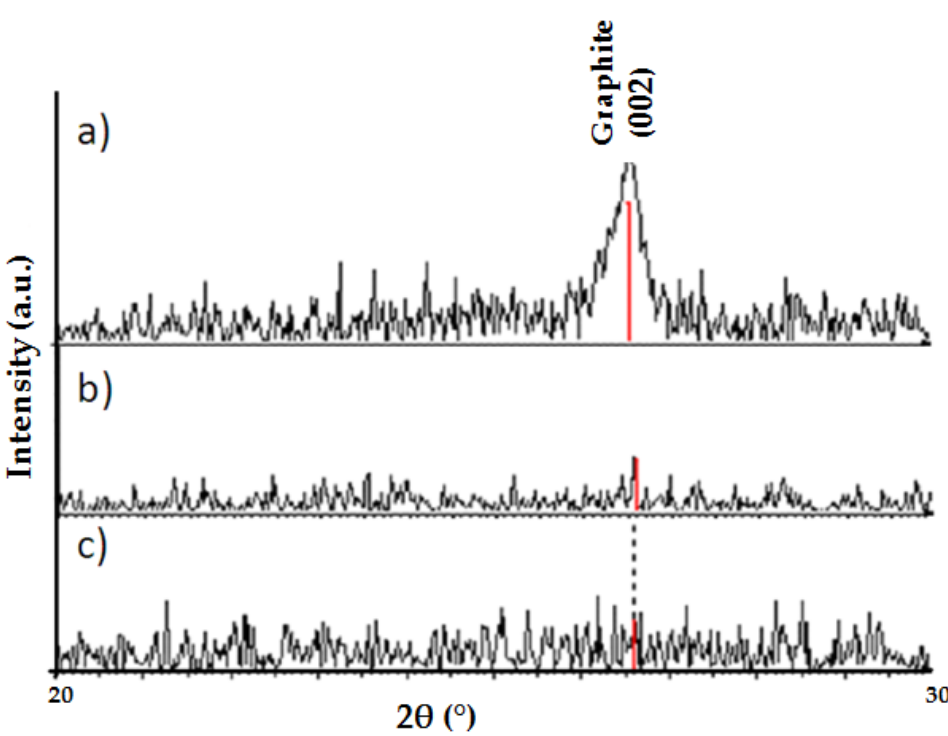
Figure 9. Diffraction patterns of WC-Co/diamond composites with different diamond particle sizes: ( a ) 2.5–5 µm, ( b ) 8–10 µm, ( c ) 16–20 µm.